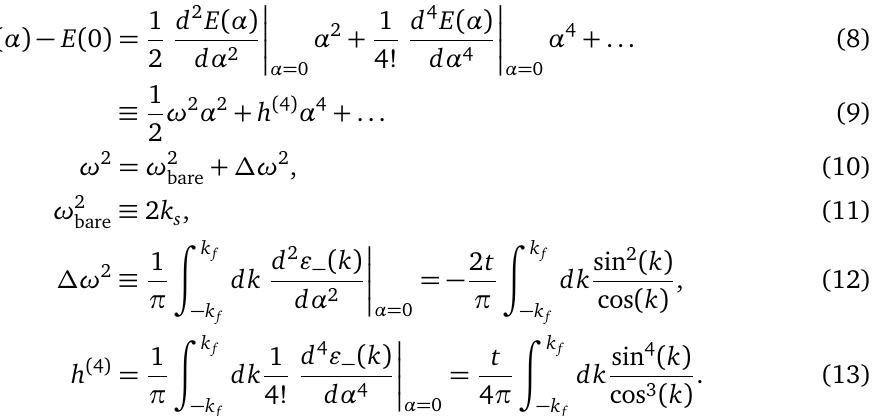
ω 2 α 2 , and the bare 2 . The black star marks s